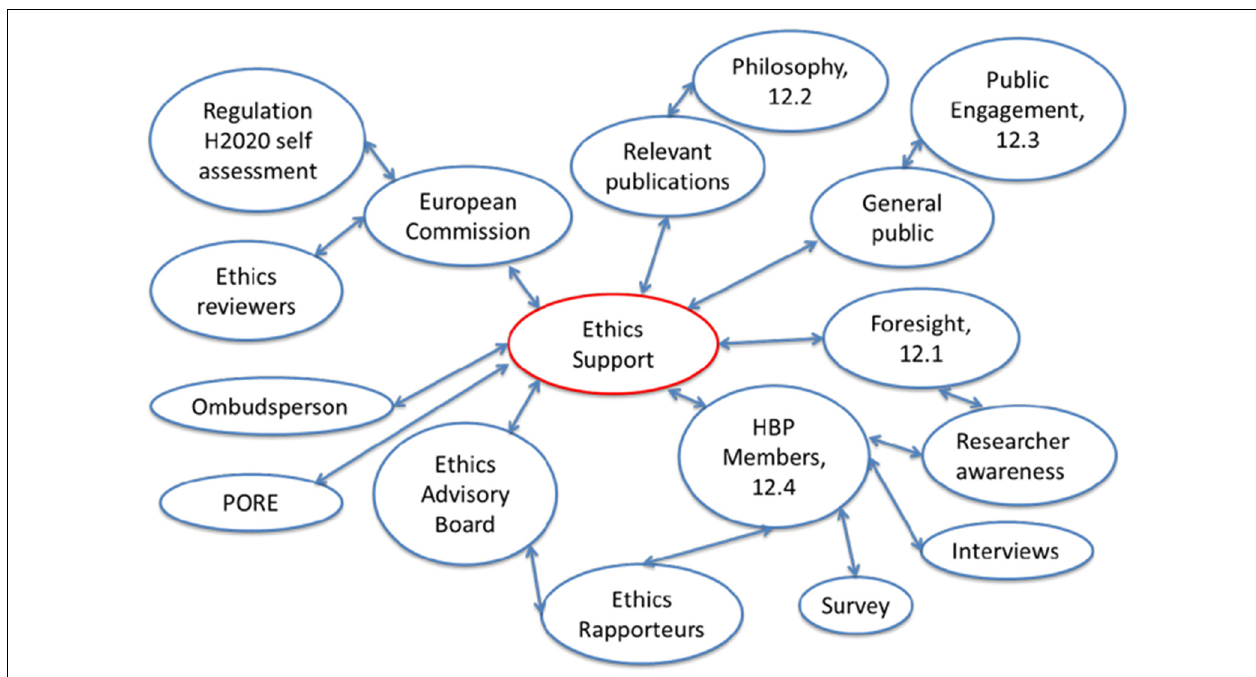
FIGURE 1 | Key participants and communication links of the Human Brain Projects (HBPs) ethics